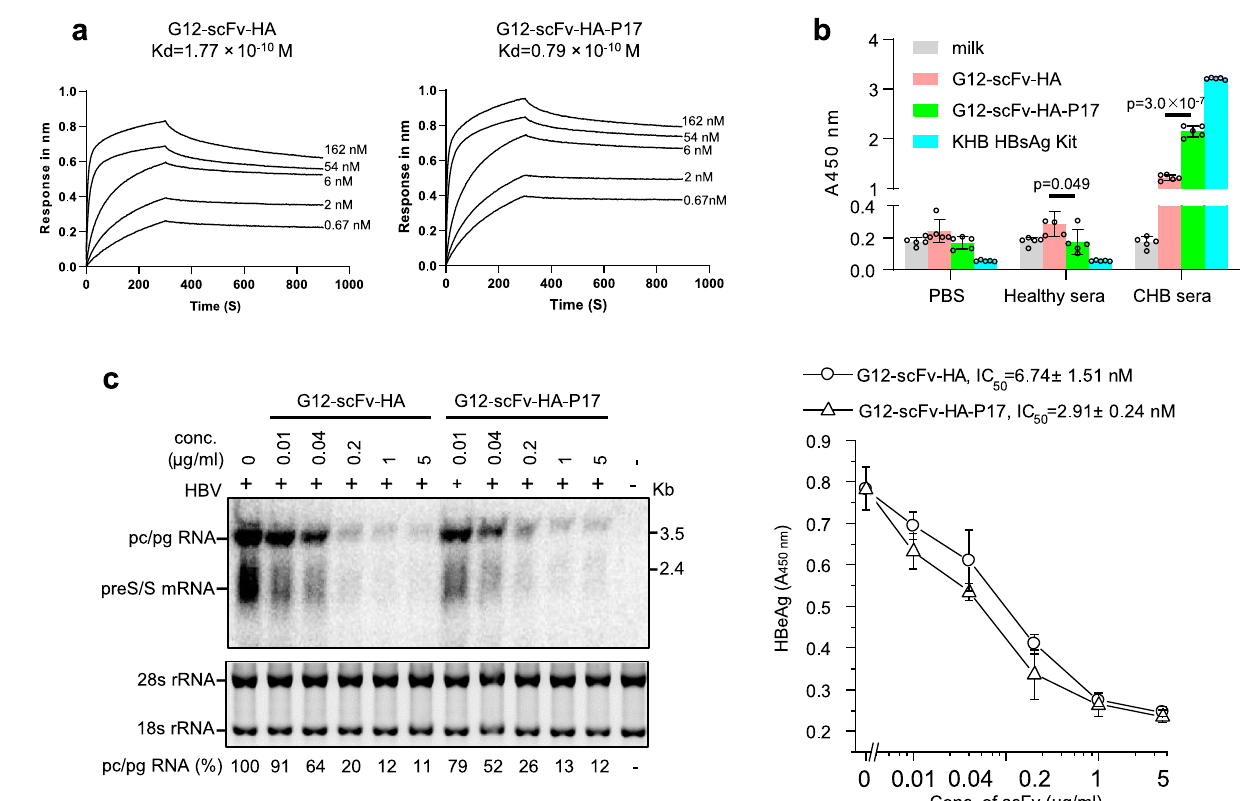
Fig. 9 | P17-tagged G12-scFv showed stronger antigen binding af fi nity and speci fi city and HBV-neutralizing activity than G12-scFv. a Biolayer inter- ferometry to determine the binding af fi nity of G12-scFv-HA and G12-scFv-HA-P17 proteinstorecombinantHBVsmallsurfaceproteinfromCHOcells.Kd,equilibrium dissociation constant. b Enzyme-linked immunosorbent assay (ELISA) to test